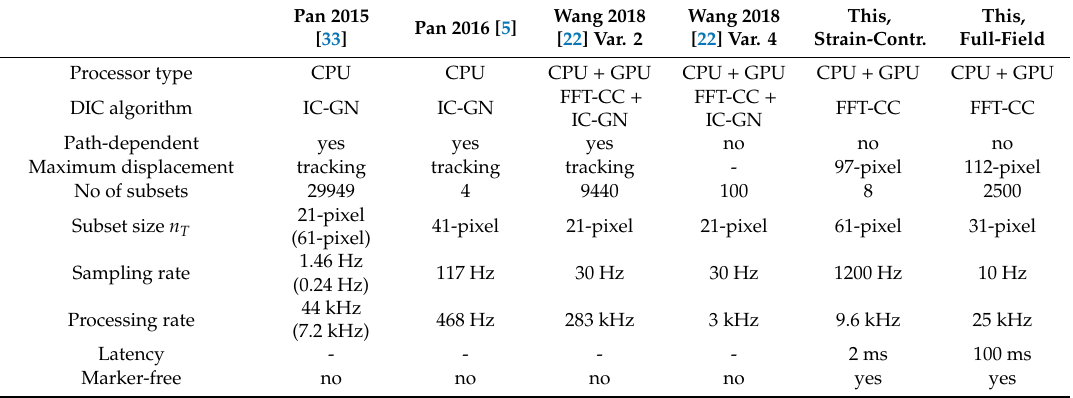
Table 2. Performance comparison of di ff erent real-time 2D-DIC systems. Parameters marked with ‘-‘ are not provided in the corresponding